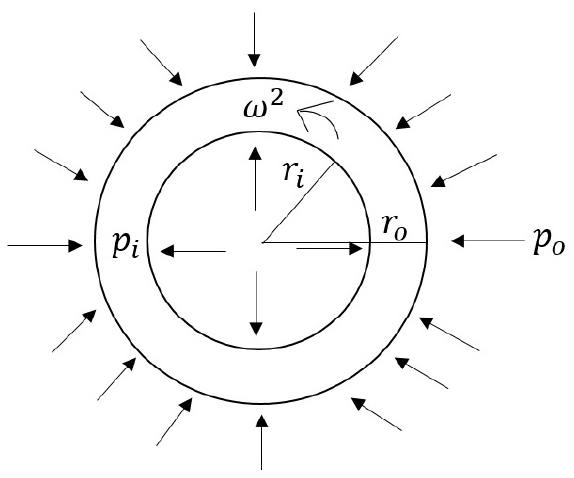
Figure 1. Cross-section of pressurized functionally graded rotating